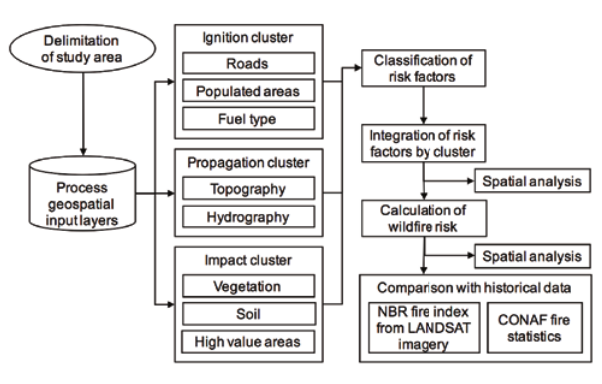
Figure 3. Final methodology diagram